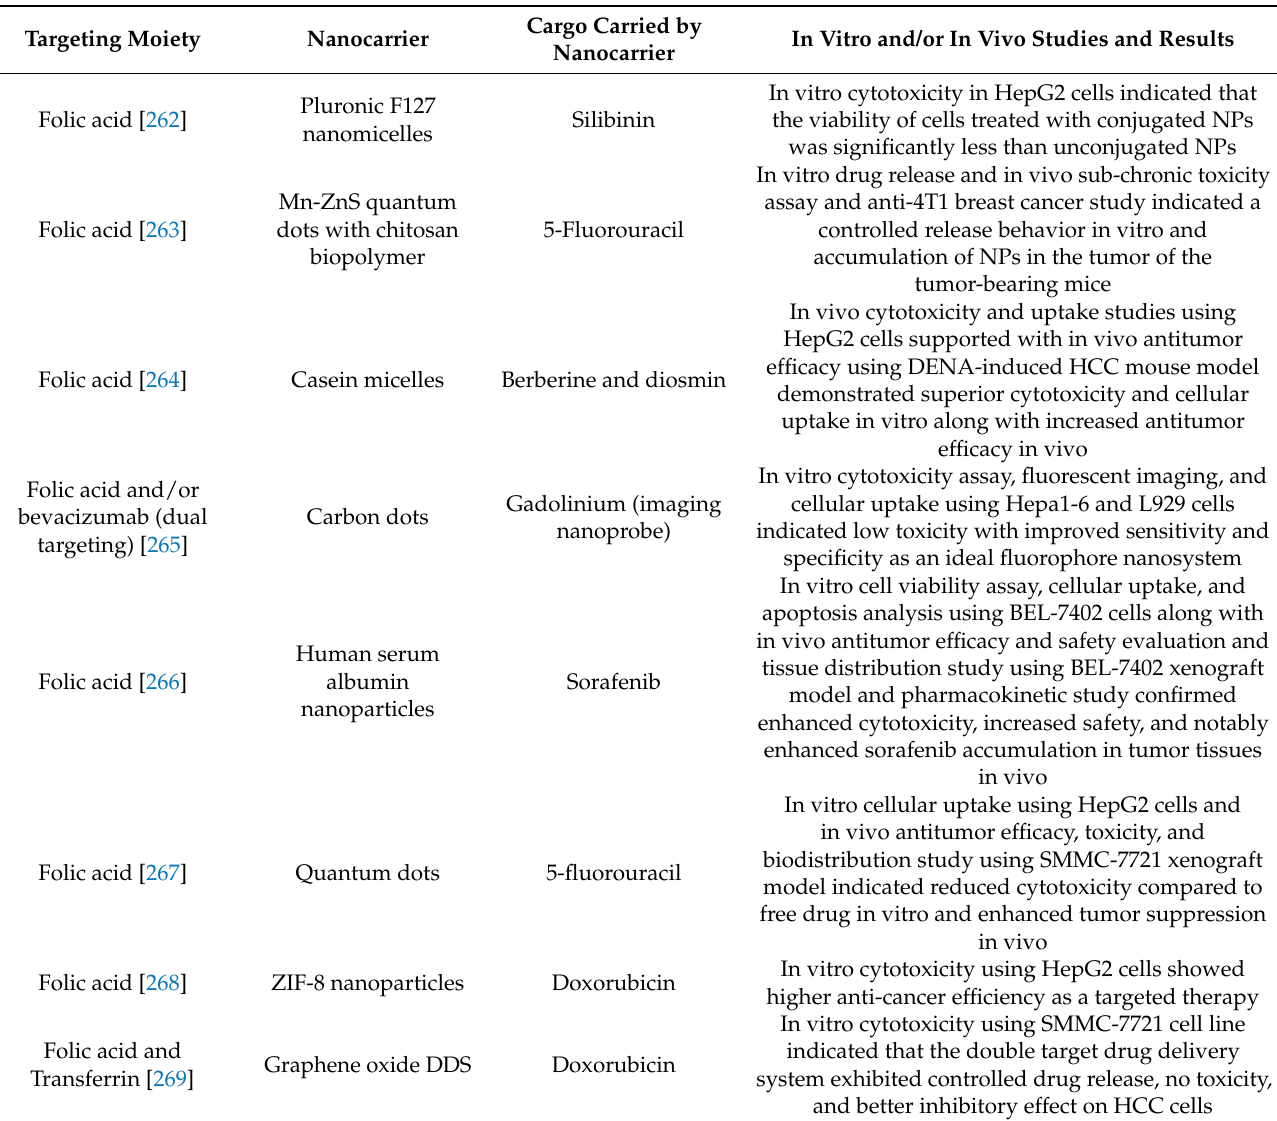
Table 5. Summary of various nanoformulations using folic acid as a potential target to deliver drugs to HCC tumor